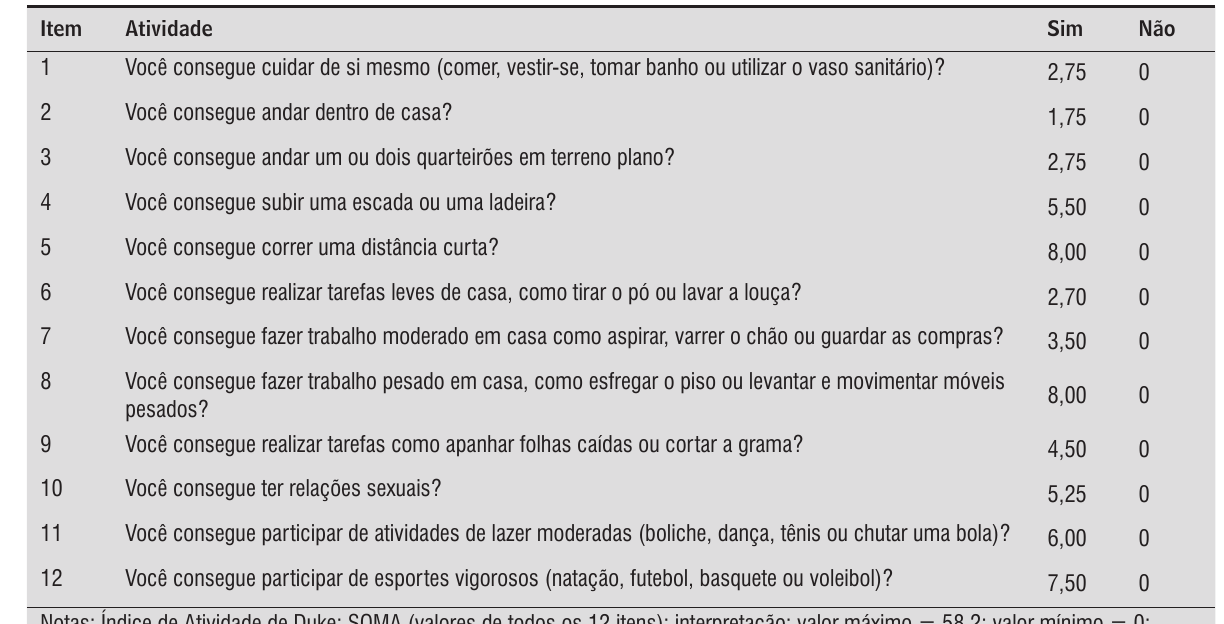
Table 1 - Duke Activity Status Index translated into Brazilian